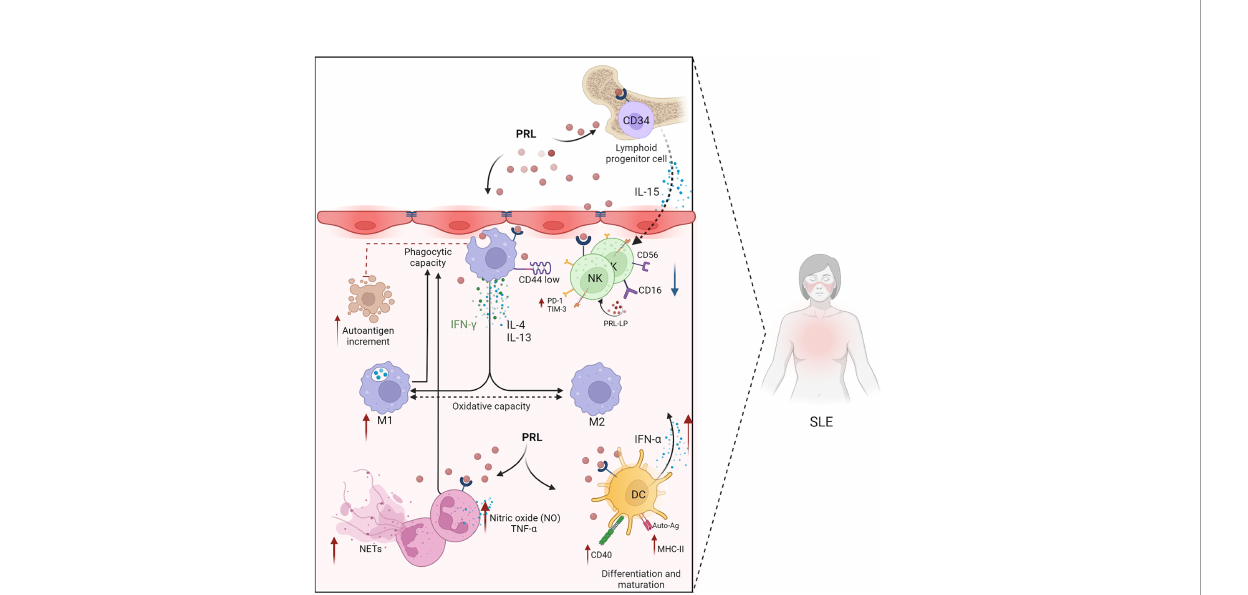
FIGURE 3 PRL in the innate immune response. PRL favors the development and progression of SLE through its intervention in the cellular mechanisms of the innate immune response (neutrophils, macrophages, dendritic cells, and NK cells). PRL exacerbates the mechanisms of cell activation and differentiation. PRL participates in the differentiation of NK cells through the modulation of IL-15 and the differentiation and maturation of dendritic cells by increasing the expression of CD40 and MHC-II. PRL decreases the phagocytic capacity of neutrophils, preventing the elimination of apoptotic bodies that could act as self-antigens capable of exacerbating the immune response, allowing autoimmunity to progress. In SLE, there is dysregulation between the M1 and M2 macrophages with a predominance in proin fl ammatory M1 macrophages, and PRL is probably involved in these mechanisms by favoring the presence of oxidative and proin fl ammatory molecules, such as IFN- g , IFN- a , and TNF- a (Created with